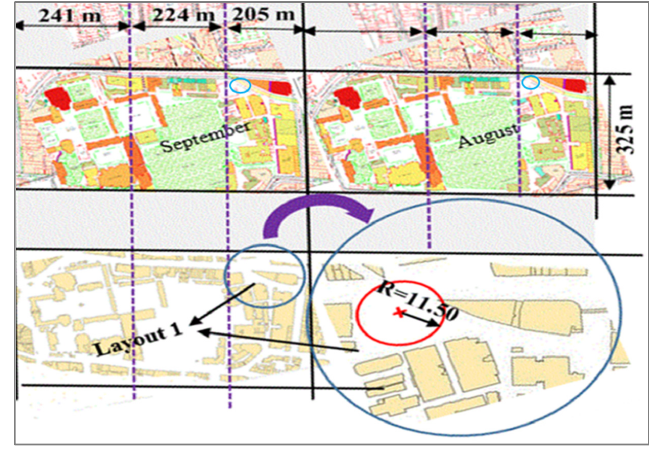
Figure 12. Determining a location for a DH thermal station.